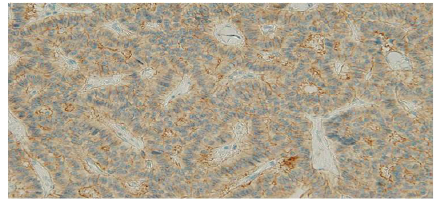
Figure 6: Somatostatin receptor type 2-stained section. Tumor cells are positive for somatostatin receptor type 2 immunostain (magnification: ×